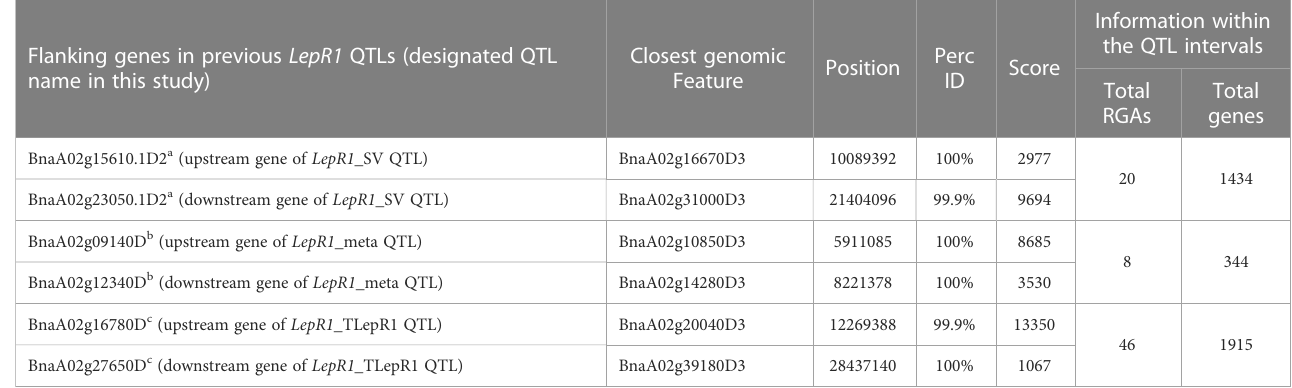
TABLE 3 Alignment (basic local alignment sequence tool or BLAST) of the fl anking genes from previous LepR1 quantitative trait loci (QTL) in chromosome A02 of Brassica napus to Darmor bzh v9.